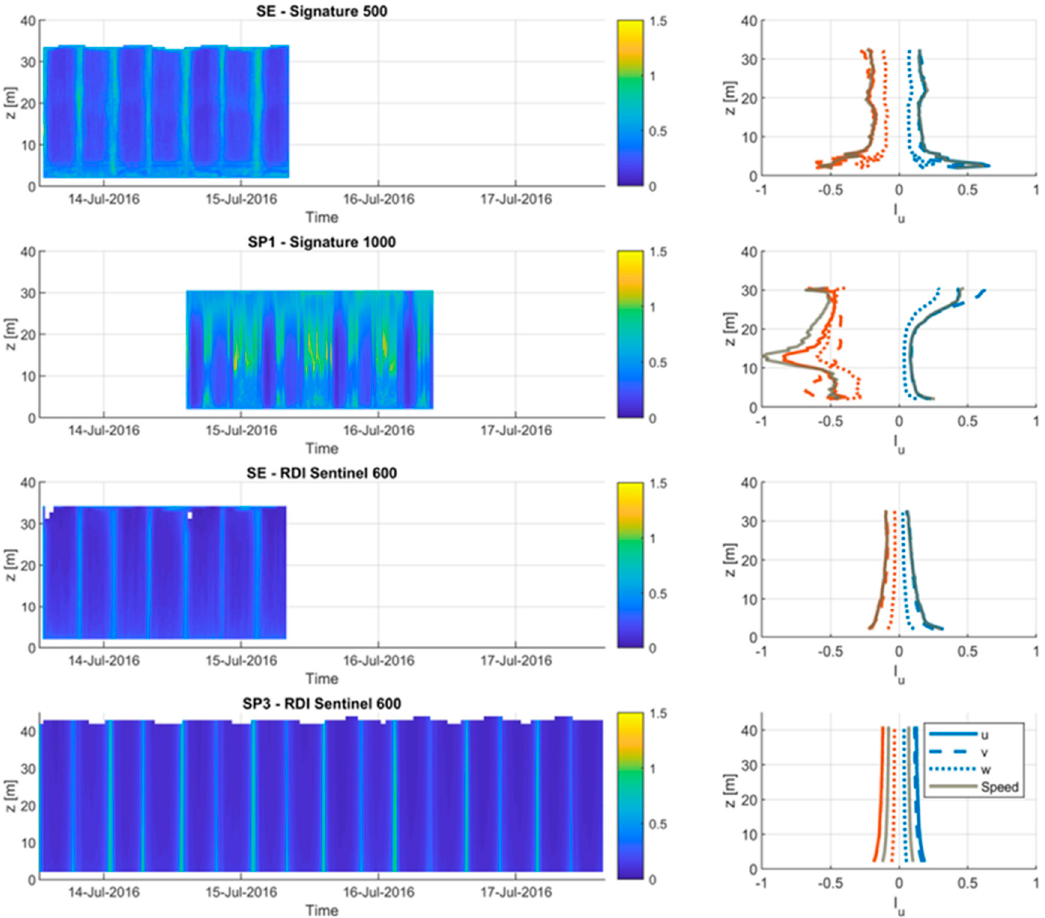
Figure 5. Turbulence intensity. Left: I u based on 10 min windows for each sensor. Right: Turbulence intensity for the first three peak velocity flood and ebb tides, where the flood is positive (blue) and the ebb tide has been made negative (red).